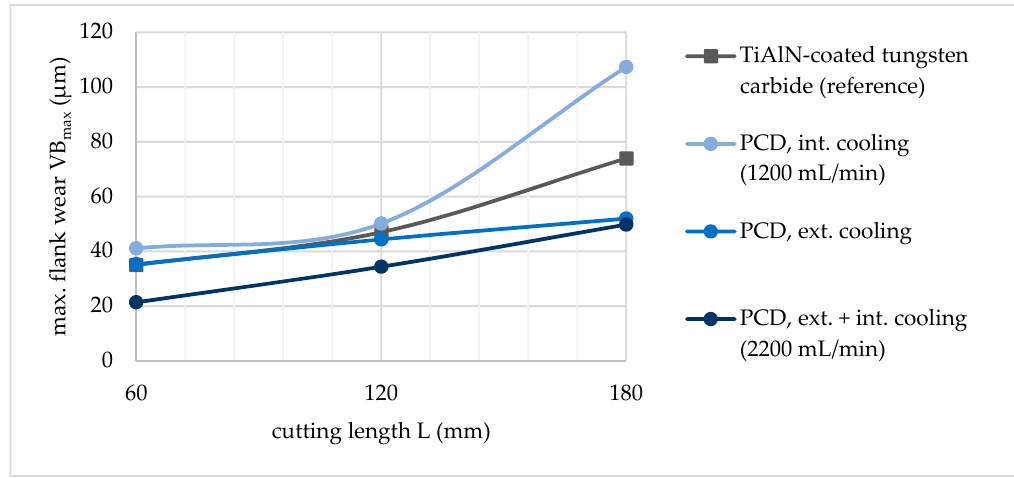
Figure 12. Progress of the maximum flank wear marks for various applied cooling strategies.